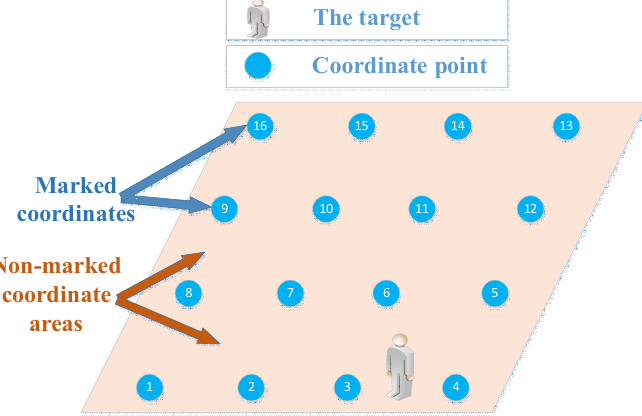
Figure 1. An illustration of target locating at the non-marked coordinate position.